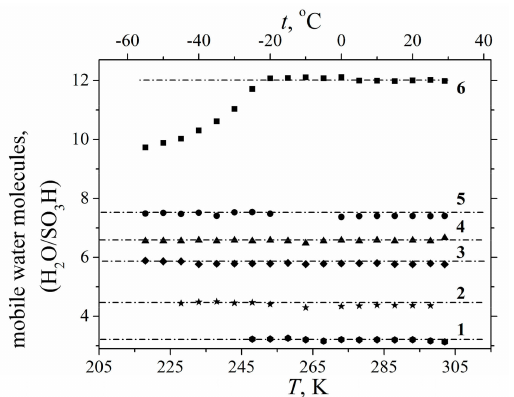
Figure 17. Dependences of mobile water molecule amount in acidic form of Nafion 117 membrane on temperature at different water content: (1) λ = 3.2 ± 0.4; (2) λ = 4.4 ± 0.4; (3) λ = 5.8 ± 0.4; (4) λ = 6.4 ± 0.4; (5) λ = 7.4 ± 0.4; (6) λ = 12 ± 0.4. Reprinted with permission from [25]. Copyright 2019 Springer Nature.